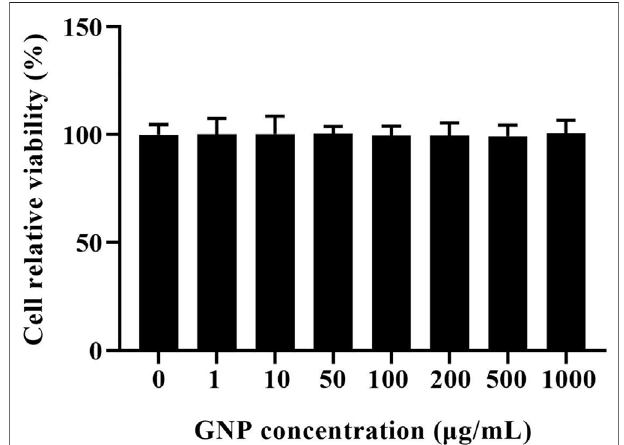
FIGURE 4 | Effect of GNP on the viability of RAW 264.7 cells. Cells were treated with GNP (10, 50, 100, and 200 μ g/ml) for 24 h. Cell viability was detected by MTT assay. Data are expressed as mean ± SD (n (cid:1) 3).